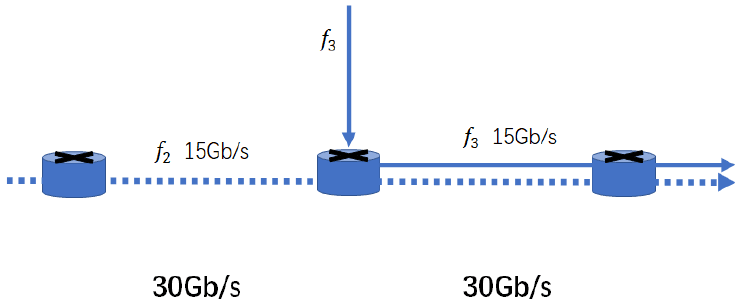
Figure 4. The bottleneck bandwidth of 𝑓 2 and 𝑓 3 .